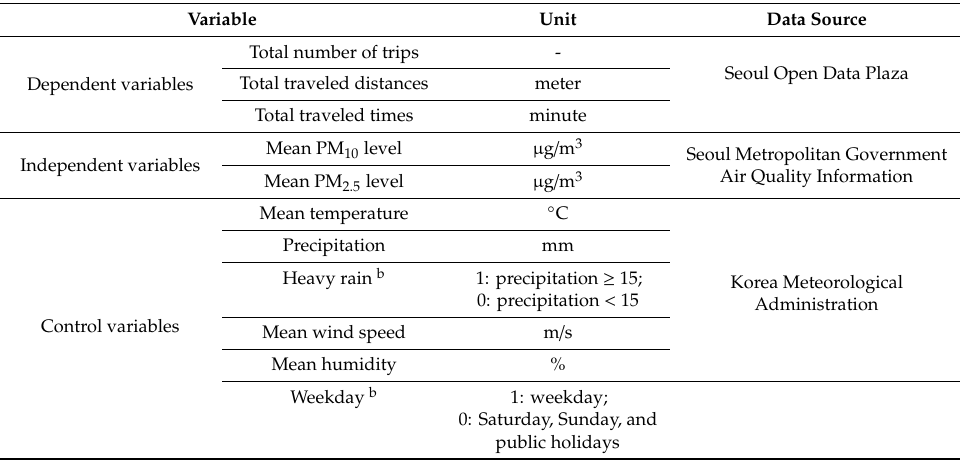
Table 1. List of variables used in this study a